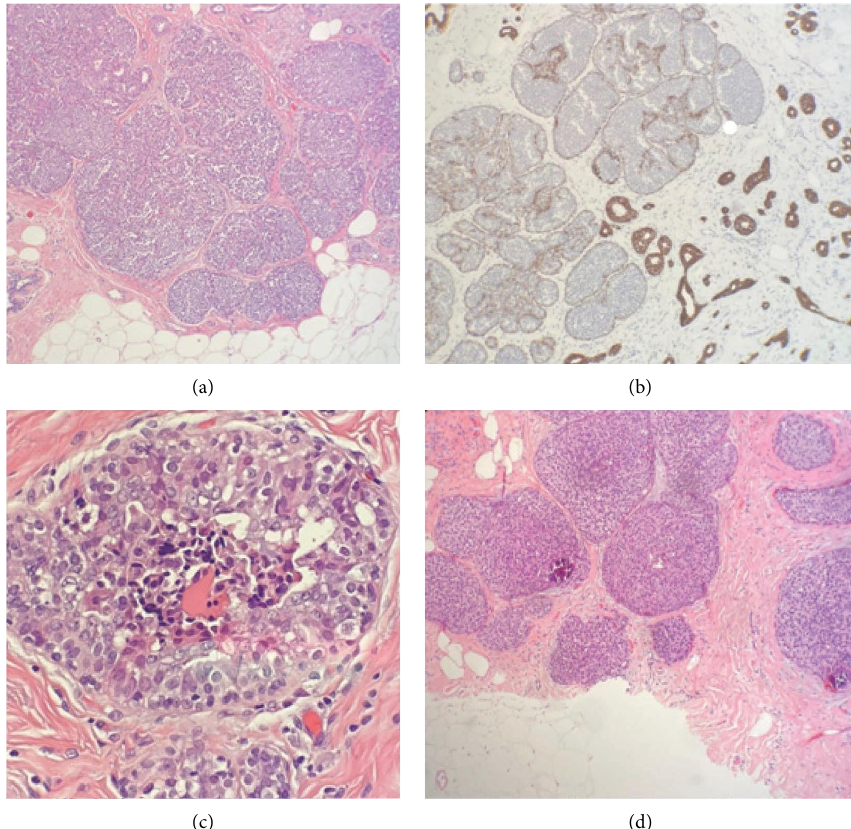
Figure 1: Classifcation of lobular carcinoma in situ. (a) Classic LCIS: H&E staining shows dyscohesive proliferation of epithelial cells in the duct lobular unit indicating lobular carcinoma in situ; more than 50% of the acini are flled and expanded by the neoplastic cells. (b) Classic LCIS: E-cadherin stain showing loss of membrane expression of the adhesion molecule E-cadherin, which is a signature feature of LCIS classic subtype. (c) Pleomorphic LCIS: H&E staining shows proliferation of dyscohesive cells with nuclear pleomorphism (enlarged nuclei, increased nuclear-to-cytoplasmic ratio, and prominent nucleoli). (d) Florid LCIS: H&E stain showing forid LCIS with marked distension of ductal lobular unit creating a confuent mass-like architecture. Tis demonstrates one of the classic features of forid LCIS of almost no intervening stroma between markedly distended acini of the involved